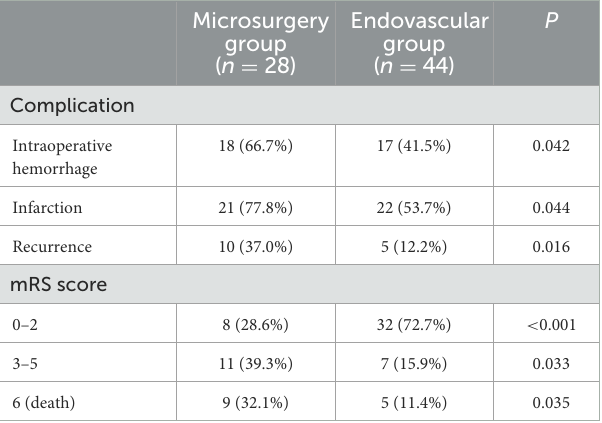
TABLE 2 Comparison of complications, postoperative recurrence, recurrence during follow-up, and outcomes at discharge in the 72 patients in the microsurgery and endovascular groups.